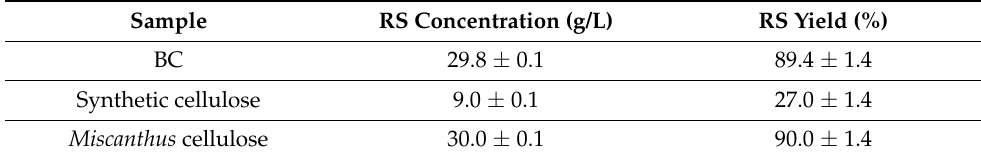
Table 4. Enzymatic hydrolysis results for cellulose